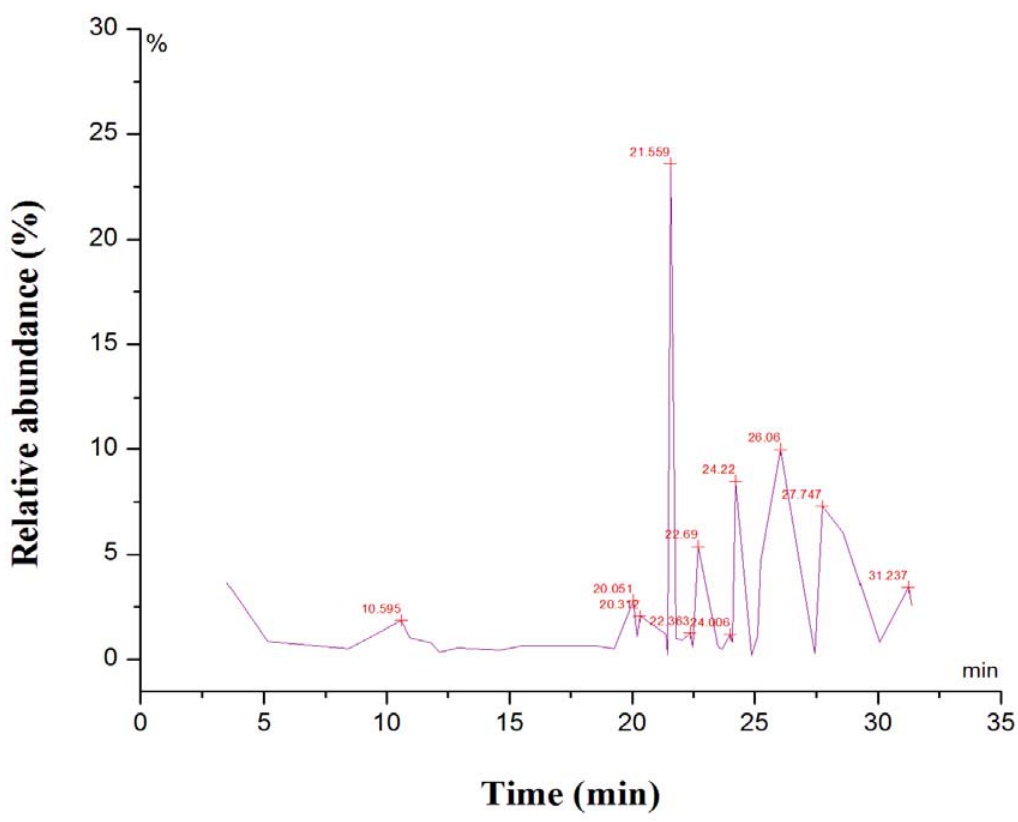
Figure 1. Representative GC-MS chromatogram for major compounds of methanolic leaf extract of Skimmia anquetilia. Table 2. Bioactive compounds of methanolic leaf extract of Skimmia anquetlia identified using GC ‐ MS analysis .